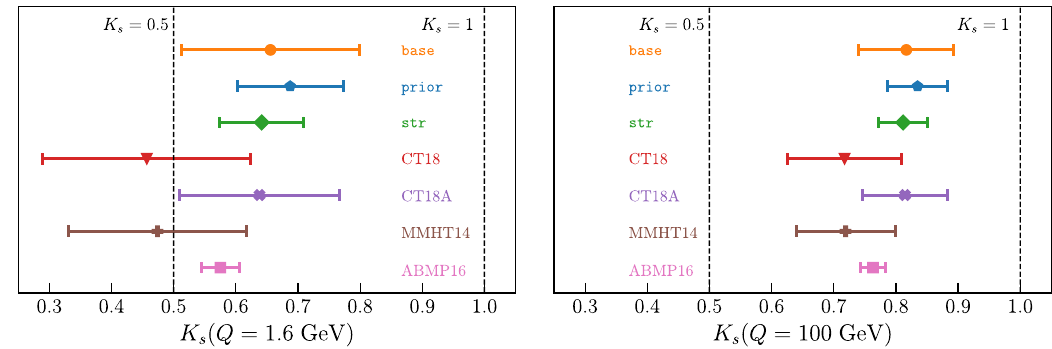
Fig. 11 The ratio K s , Eq. (3.1), for Q = 1 . 6 GeV (left) and Q = 100 GeV (right). The PDF sets are the same as in Fig.